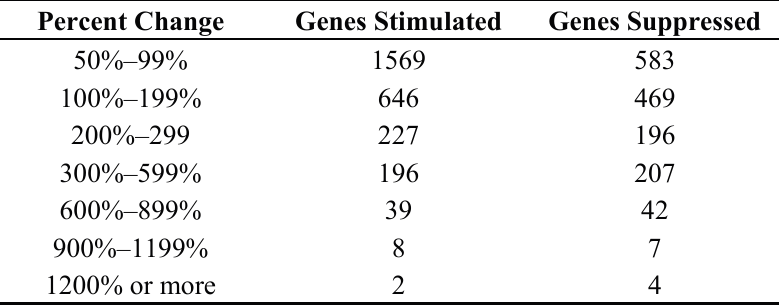
Table 2. Estimate of number of genes affected by